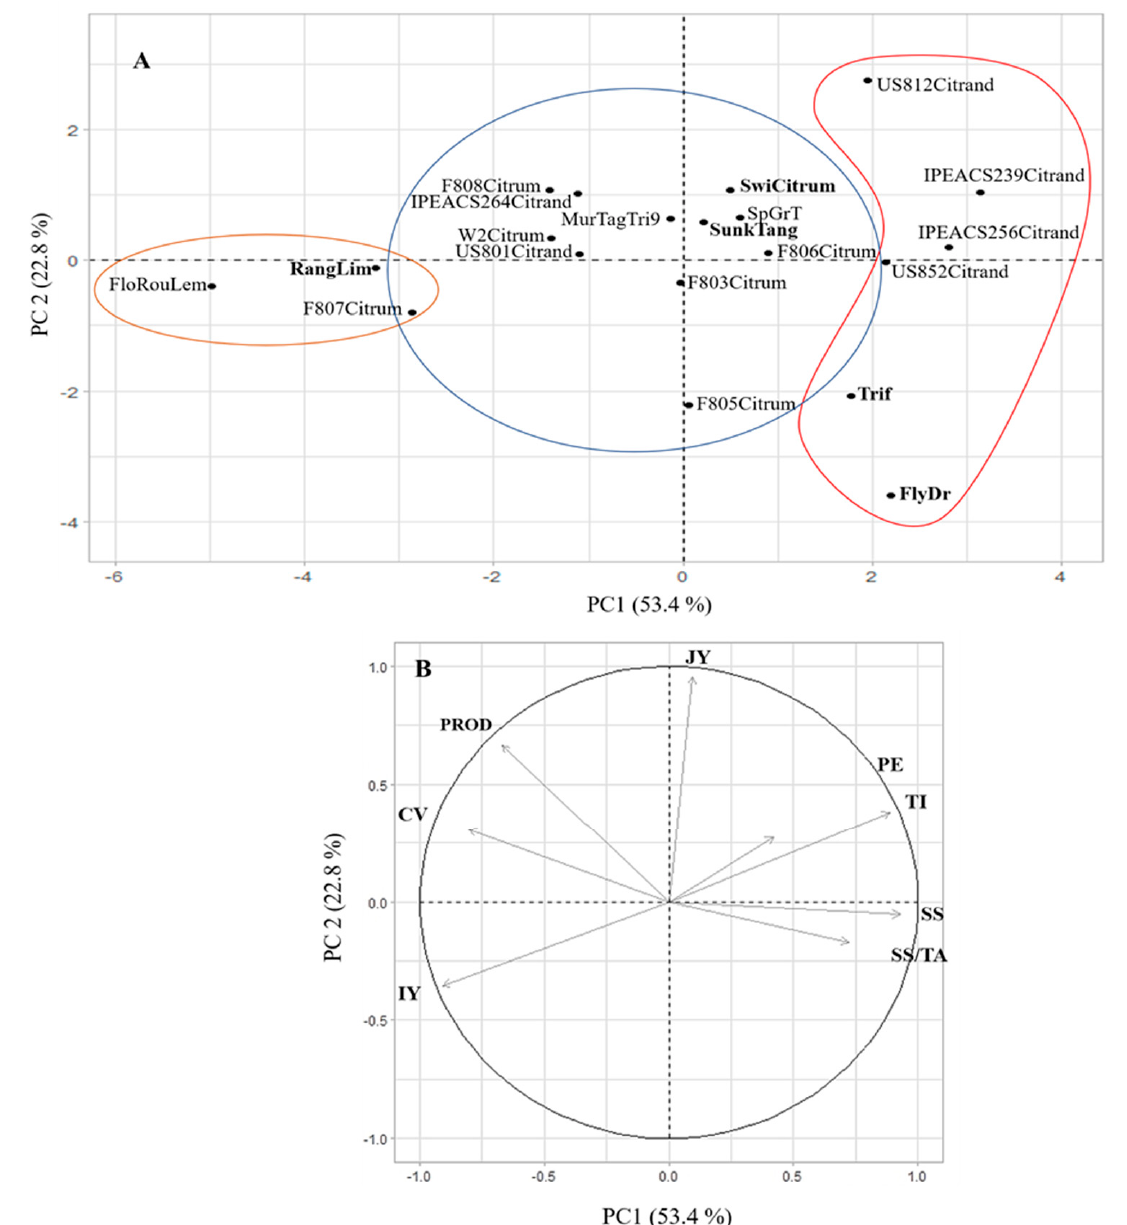
Figure 1. Principal components analysis (PCA) of production (PROD), canopy volume (CV), production efficiency (PE), technological index (TI), soluble solids (SS), maturation index (SS/TA), industrial yield (IY) and juice yield (JY) of ‘Valencia’ sweet orange grafted onto 20 rootstocks. ( A ). Treatment dispersion according to the scores of the principal components. ( B ). Variable arrangement according to the scores of the principal components. US852Citrand: ‘US–852’ citrandarin;